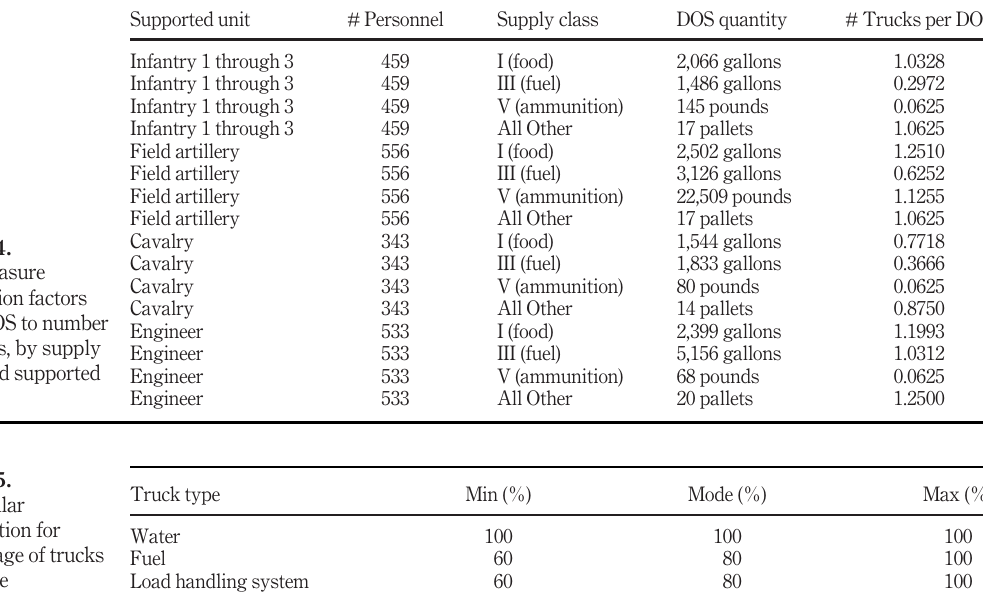
distribution for percentage of trucks available